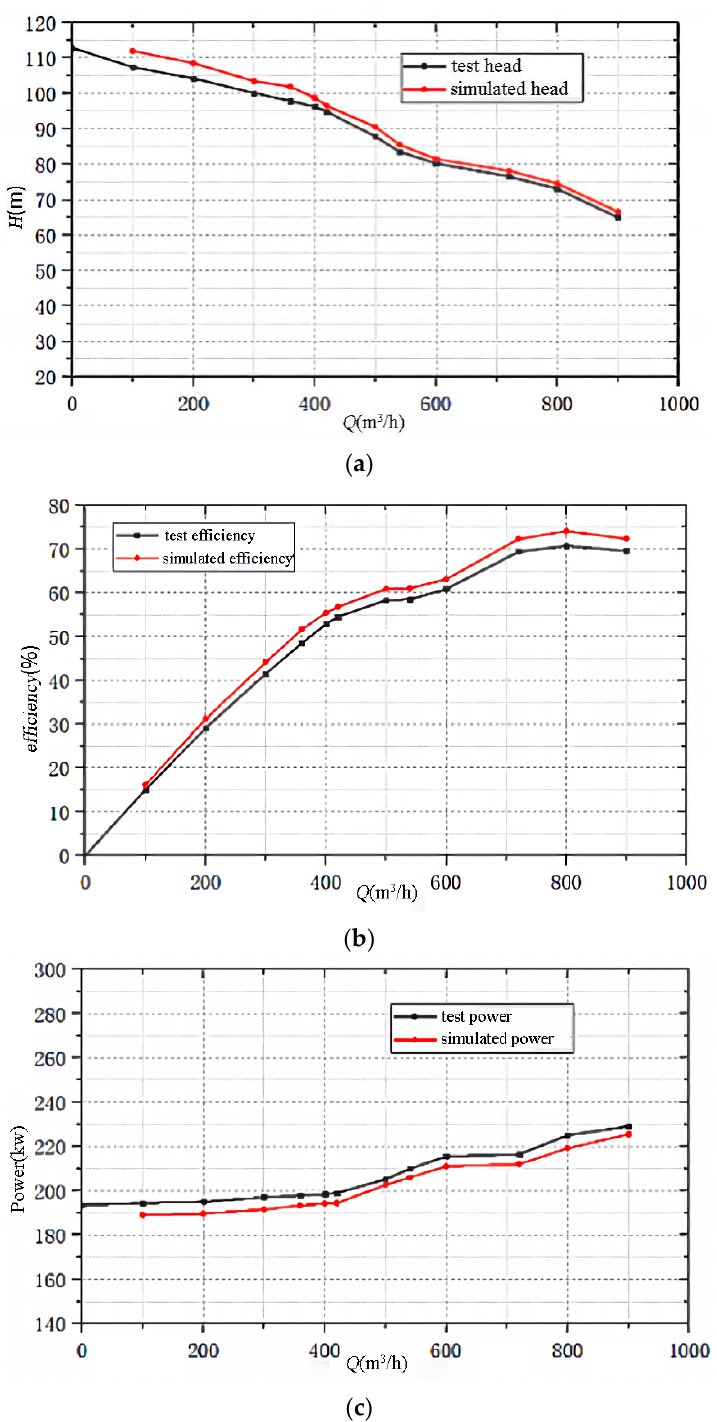
Figure 25. Performance curves of the mining pump under thirteen flow conditions: ( a ) flow-head curve; ( b ) flow-efficiency curve; ( c ) flow-shaft power curve.